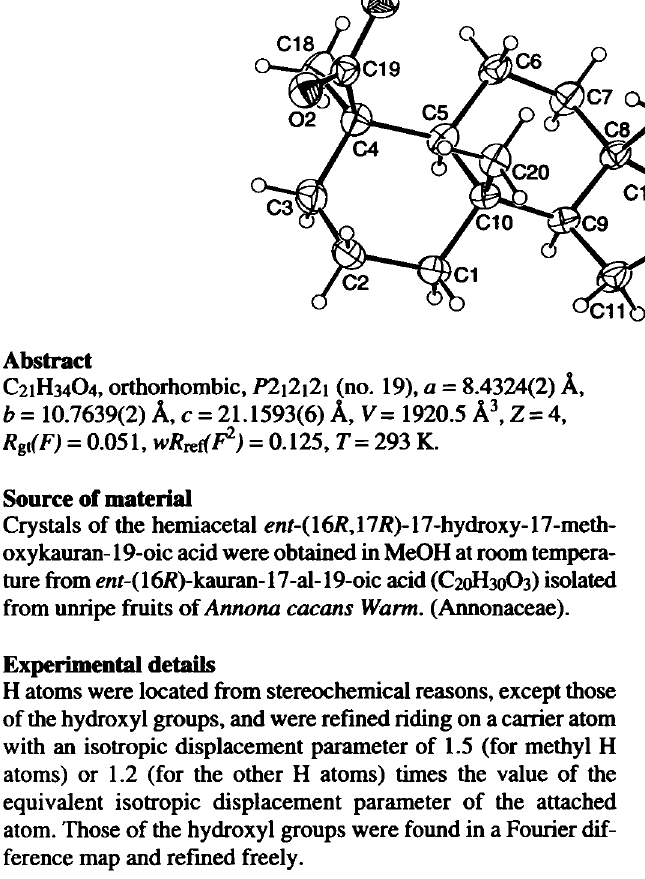
Table 1. Data collection and